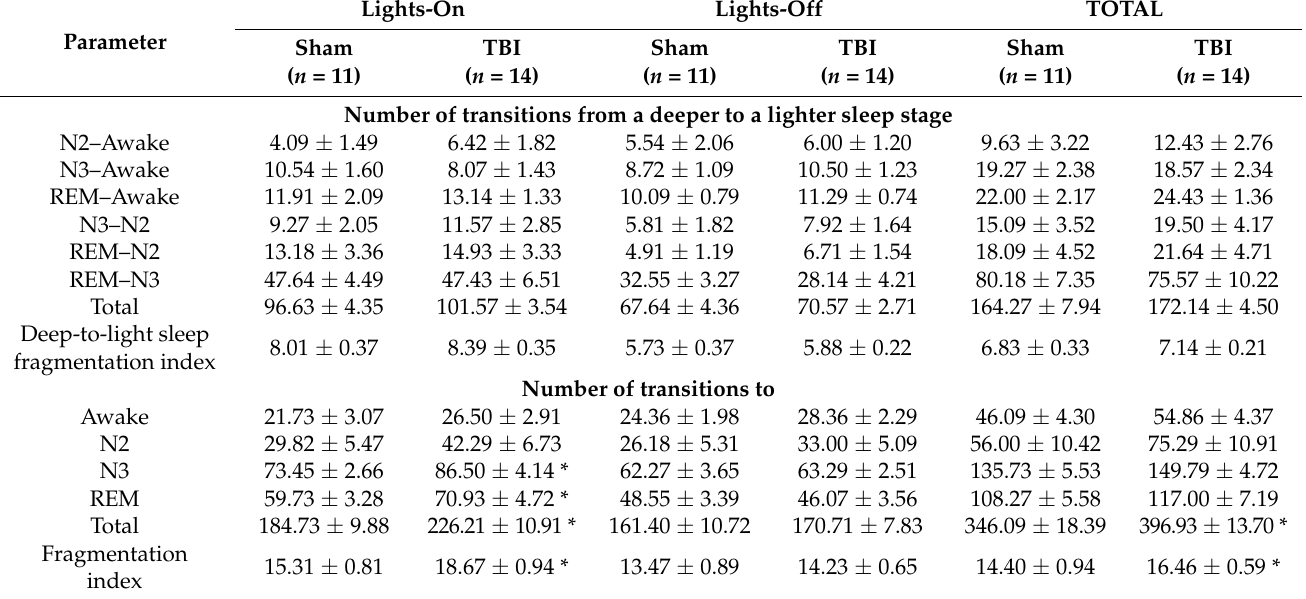
Data are shown as the mean ± standard deviation of the mean. Statistical significance: * p < 0.05 compared with the sham group (Mann–Whitney U test). Abbreviations: N2, N2 sleep stage; N3, N3 sleep stage; REM, rapid eye movement sleep; TBI, traumatic brain injury; W, awake.